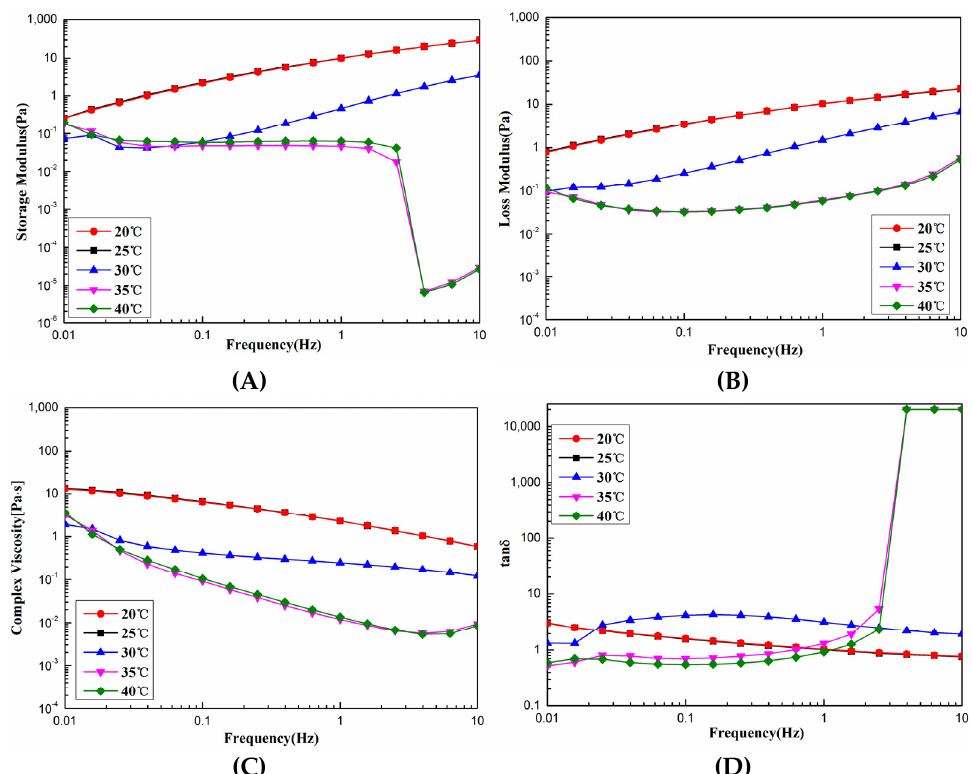
Figure 5. Dynamic rheological curve of SCSC at different temperatures. ( A ) Storage modulus (G ′ ); ( B ) loss modulus (G”); ( C ) complex viscosity ( η *); ( D ) tan δ .